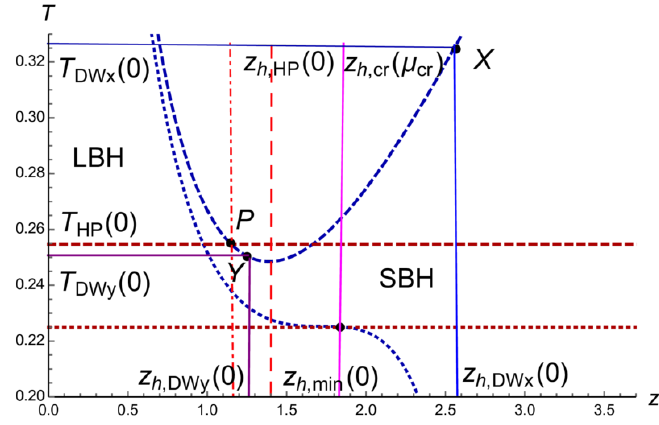
Figure 41 . The plot explains the di(cid:11)erence between phase diagrams for Wilson lines W x and W y for (cid:23) = 4 : 5. The coordinates of points X,Y and P are ( z h;DWx (0) ; T DWx (0)), ( z h;HP (0) ; T HP (0)) and ( z h;DWx (0) ; T DWx (0)). We see that P is in the SBH region, and X in the LBH region. The red dashed and point-dashed lines, and the magenta line are the same as at (cid:12)gure 34.